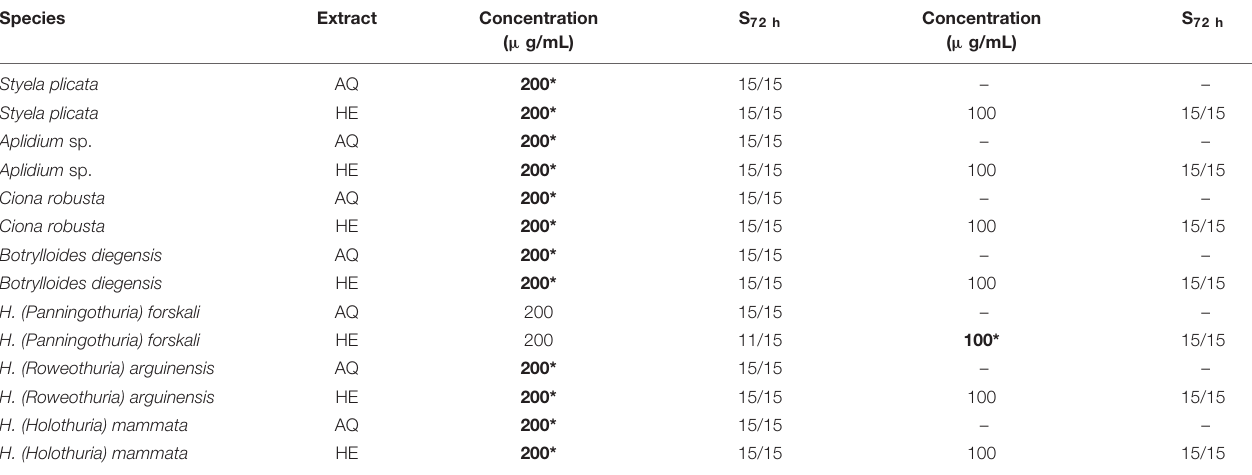
TABLE 4 | Acute developmental toxicity of the AQ and HE extracts from sea cucumbers and tunicates assessed in zebrafish larvae. Species Extract Concentration